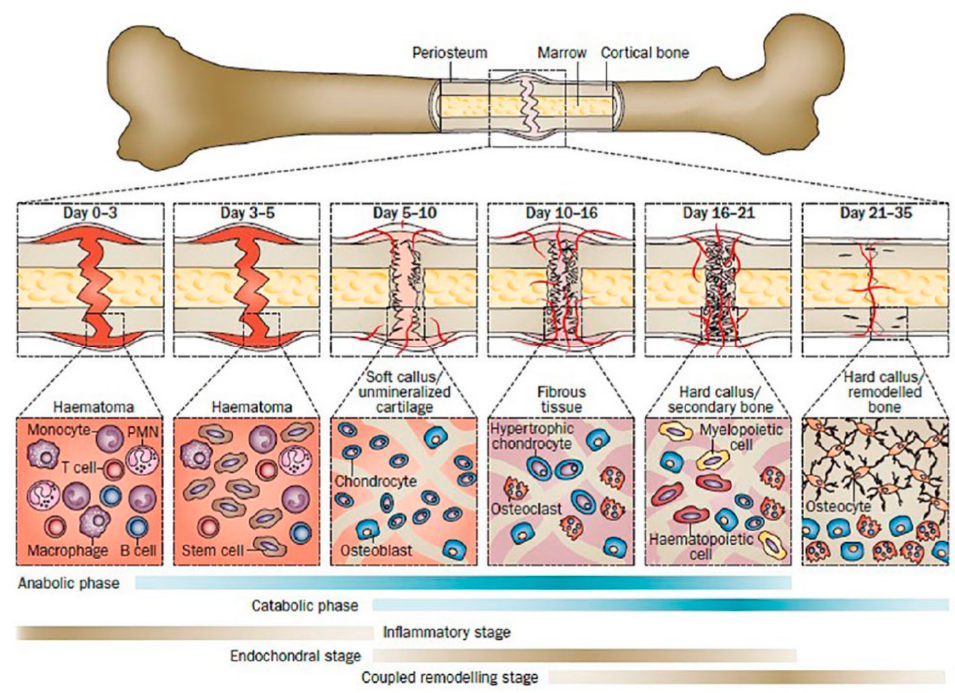
Figure 3. Healing stages of mouse closed femur fracture fixed with an intramedullary rod. Adapted with permission from Einhorn et al. (2015) [10] Copyright Springer Nature, 2014.